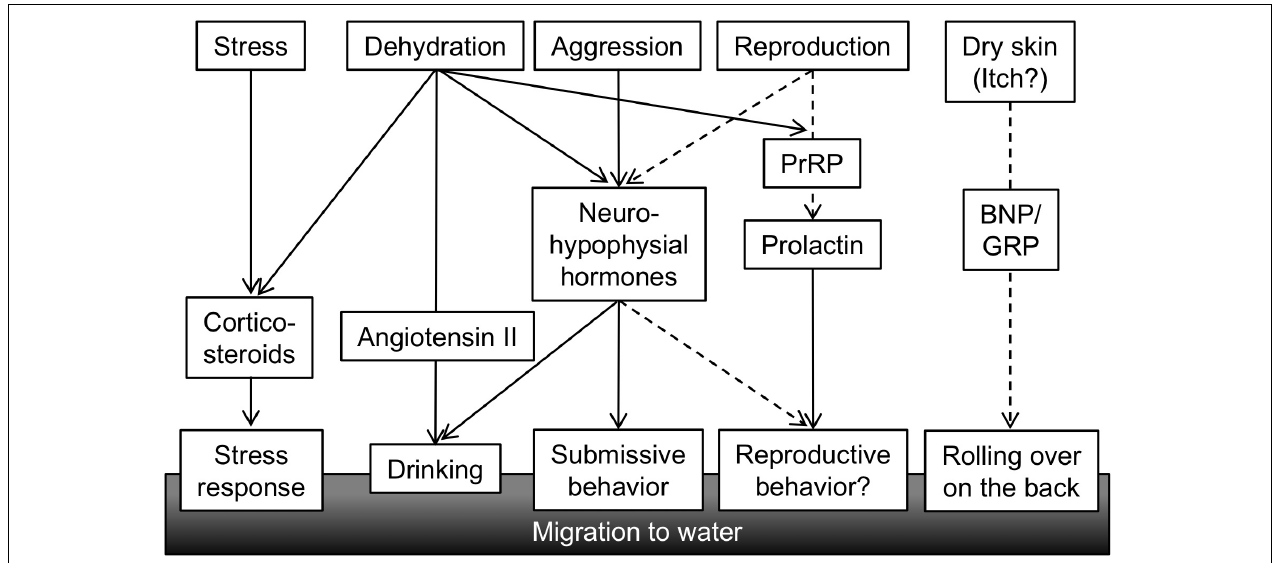
FIGURE 5 | A conceptual diagram of hormones regulating amphibious behavior of mudskippers. Various stimuli related to the amphibious lifestyle of mudskipper activate secretion of hormones, which in turn leads to behavioral and physiological outputs. Solid lines showing functional associations are based on published data, while broken lines are speculation. PrRP, prolactin-releasing peptide; BNP, B-type natriuretic peptide; GRP, gastrin-releasing